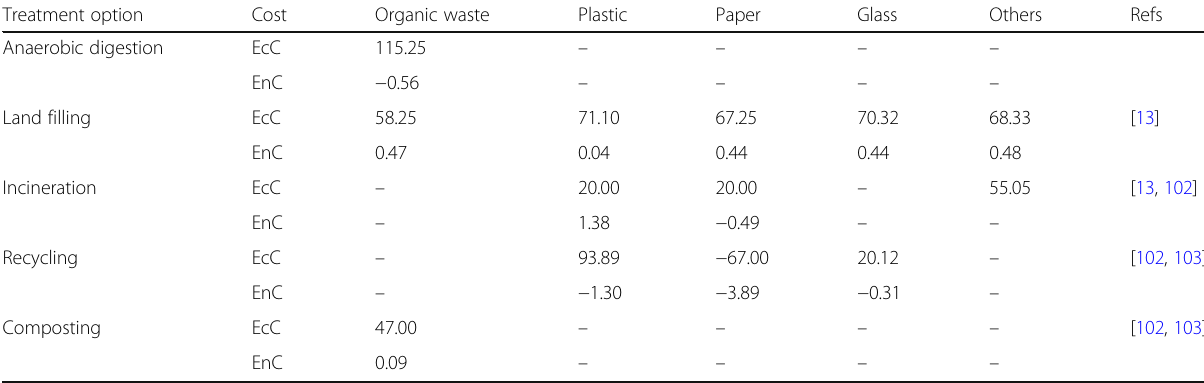
Table 6 Average economic and environmental cost of municipal solid waste treatment options (USD t − 1 ) Treatment